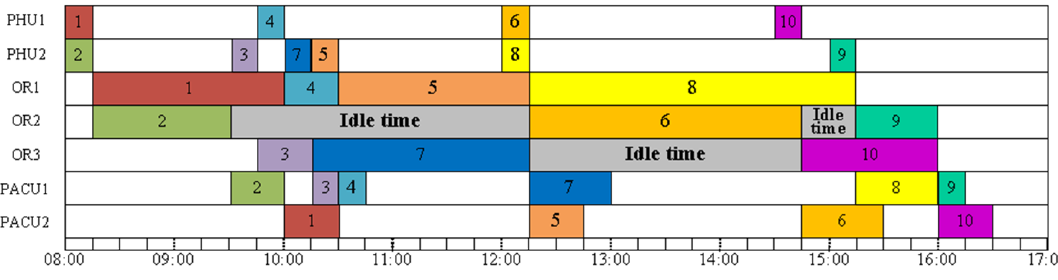
Figure 2. A feasible solution 1 for Example A.